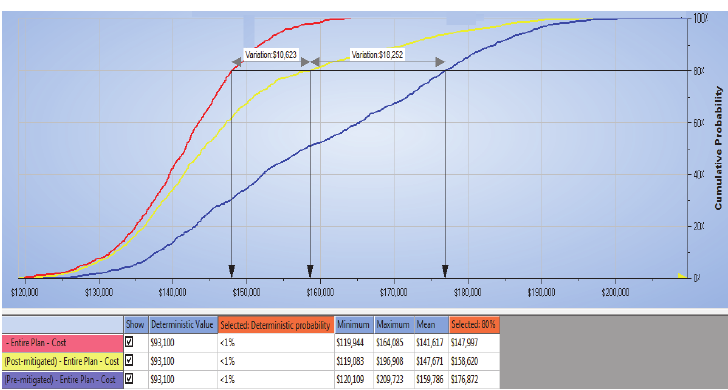
Fig. 7. Simulation of the project completion dates for three plans